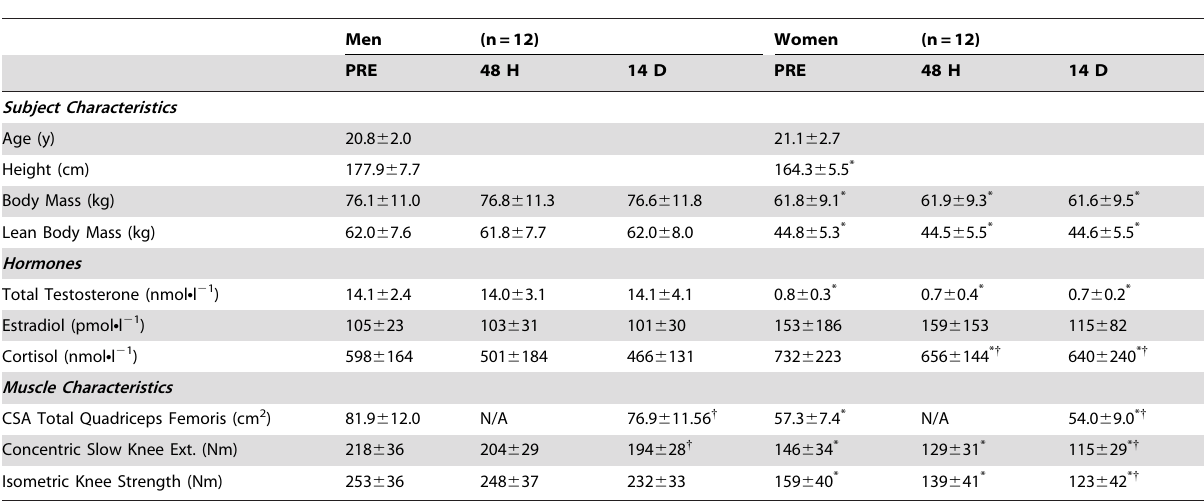
Table 1. Subject